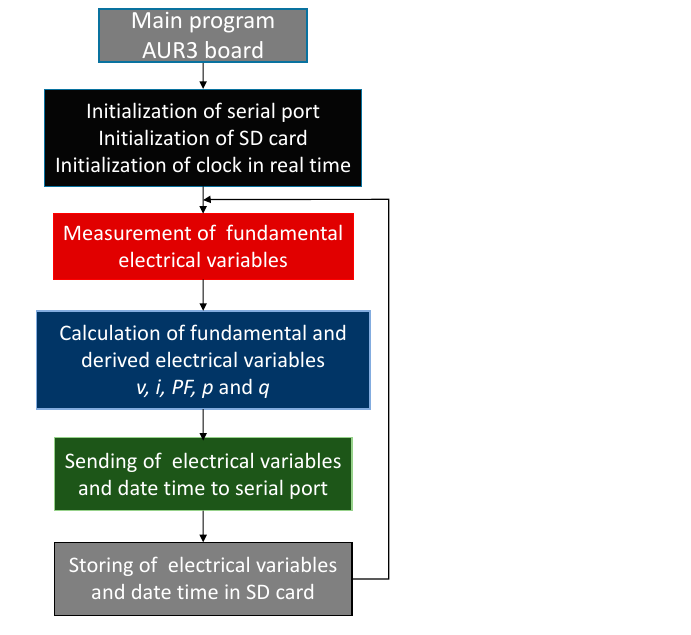
Figure 5. Flowchart for the measurement and computation of the electric variable: AUR3 board.